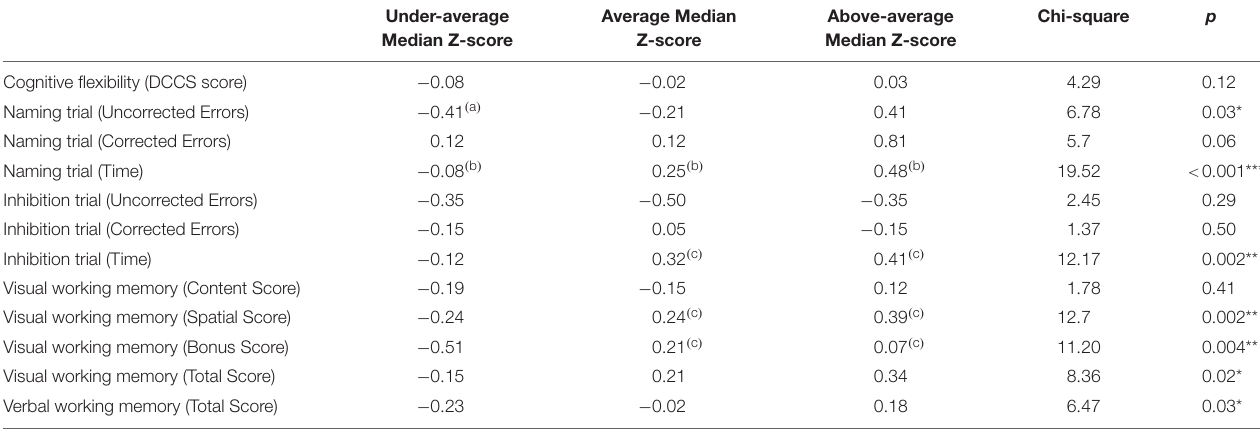
TABLE 3 | Differences in results of executive functioning test between three defined groups of children based on the composite physical fitness score.